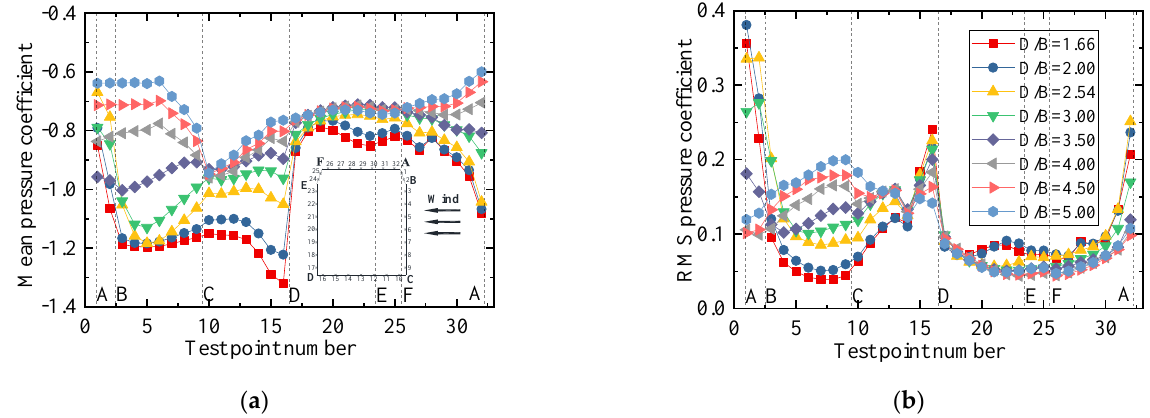
Figure 23. Wind pressure coefficient of Case 4: ( a ) Mean value of the downstream vehicle; ( b ) RMS value of the down- stream vehicle.